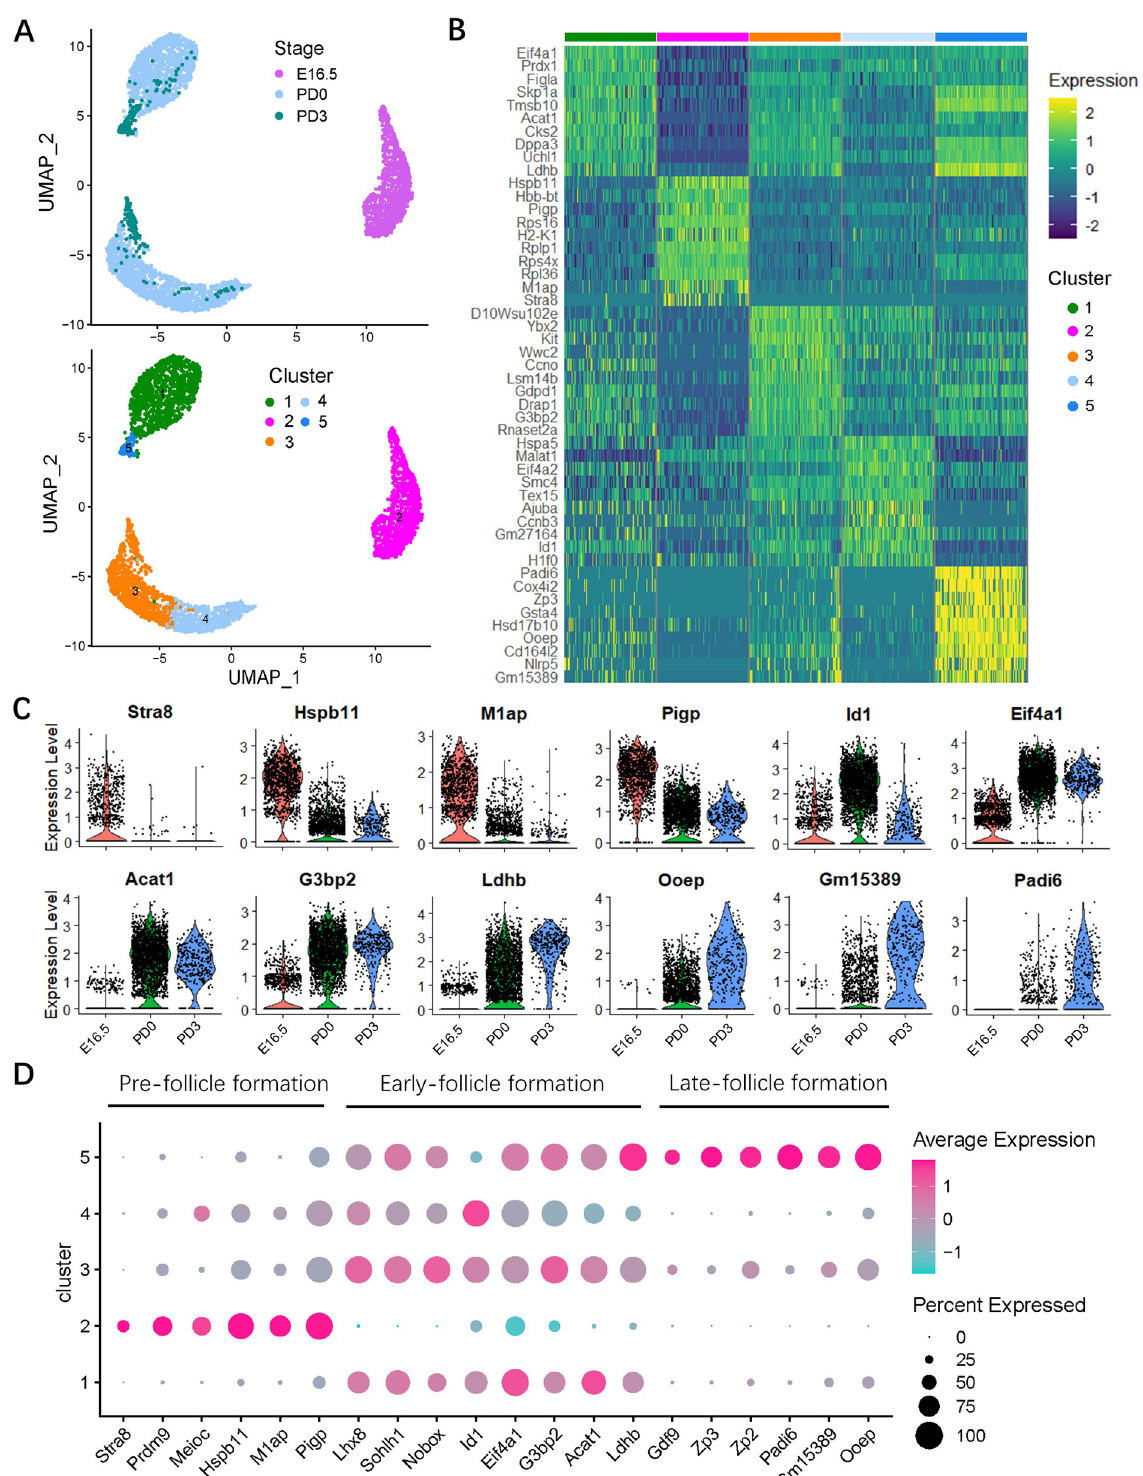
Fig 2. Molecular characterization of the germ cell subsets. ( A ) Cluster analysis of germ cells with UMAP plots based on developmental timeline (upper) and transcriptional patterns (below). ( B ) Heatmap of top 10 marker genes of the germ cell clusters. Top 50 marker genes in each cluster are shown in S2 Table. (C) Vlnplots of the expression level of representative genes along with developmental timeline. (D) Dot plot of general and stage-specific (pre-, early- and late-follicle formations) germ cell marker genes expressed in cell clusters. Dot size represents the